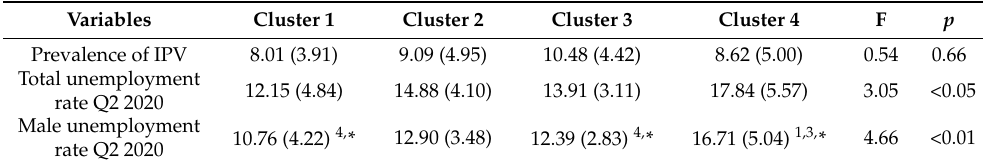
Figure 2. Distribution of Spanish provinces by cluster according to the percentage change in 016-call rates and PO rates in the Second Quarter (2019–2020). Table 3. Means, standard deviations (in parentheses), and ANOVA results for the four variables in relation to provincial clusters for Intimate Partner